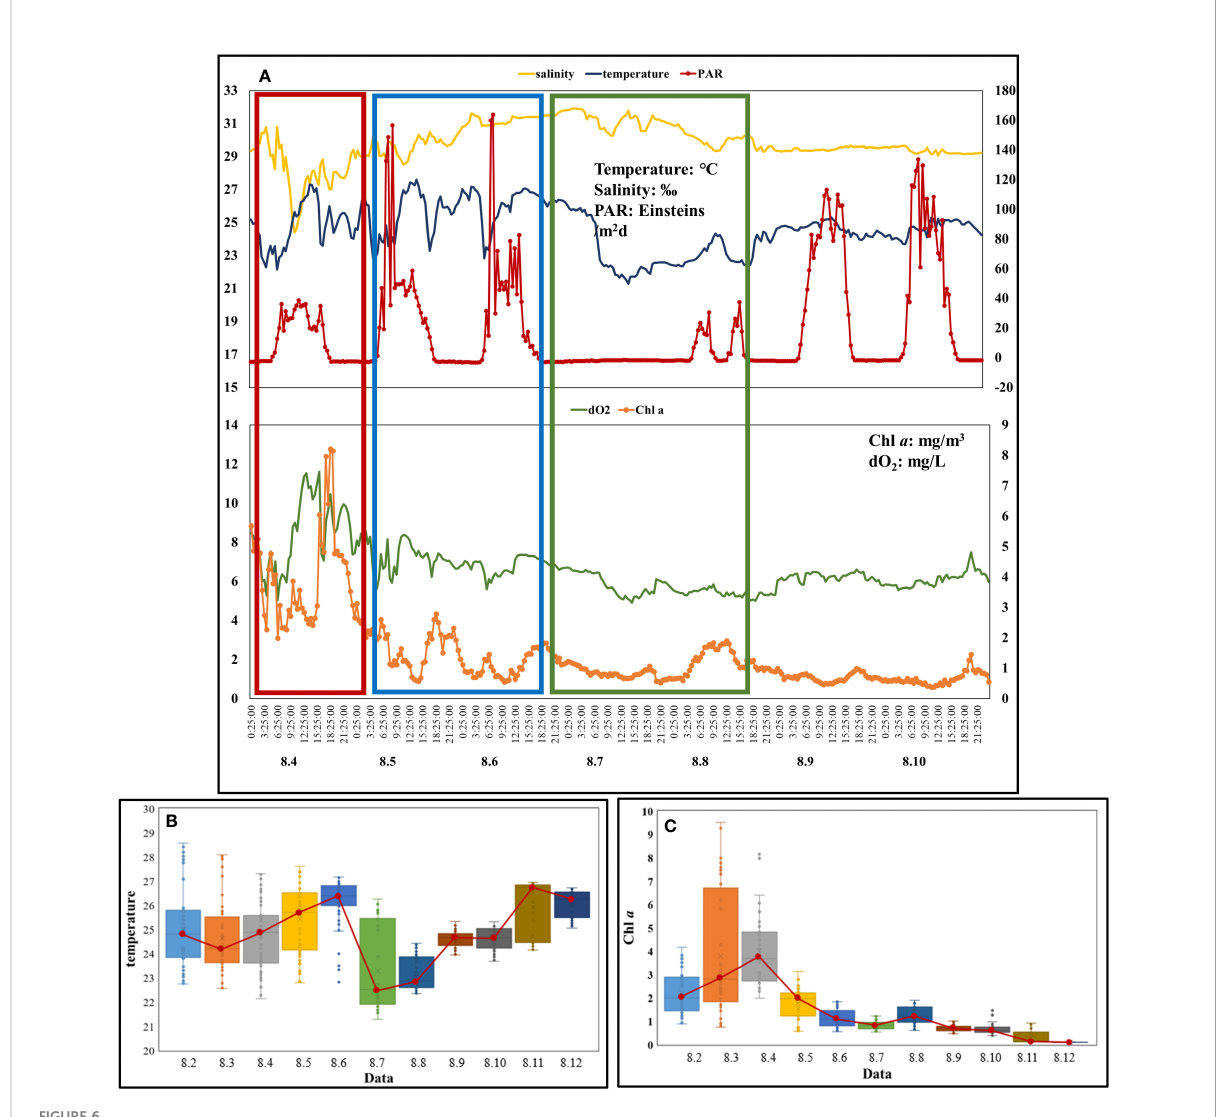
FIGURE 6 The variations of parameters measured by buoy during typhoon “ Muifa ” . The variations when the typhoon passes are marked with red box. The typhoon passed through the Yangtze Estuary on August 7. The red, green and blue boxes represent several typical situations analyzed in the paper. (A) show the daily changes before, during, and after the typhoon, (B, C) show the Chl a and temperature changes with box plots,